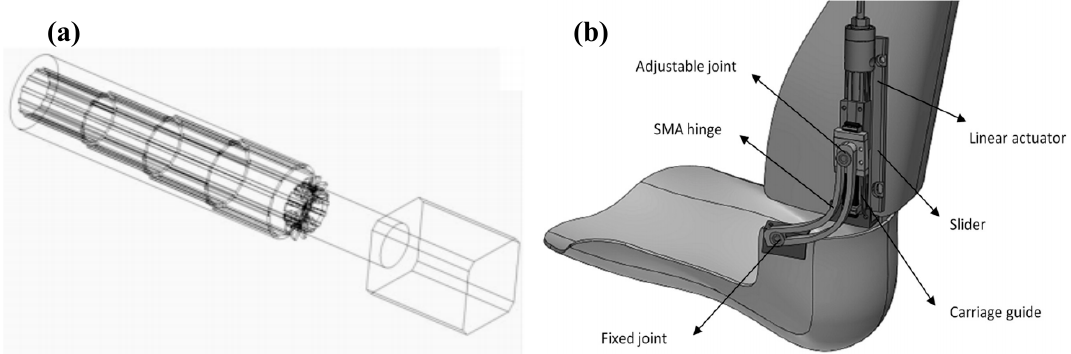
Figure 23. ( a ) Adjustable superelastic tube, and ( b ) adjustable superelastic hinge that provides the required level of stiffness in different walking conditions [53].